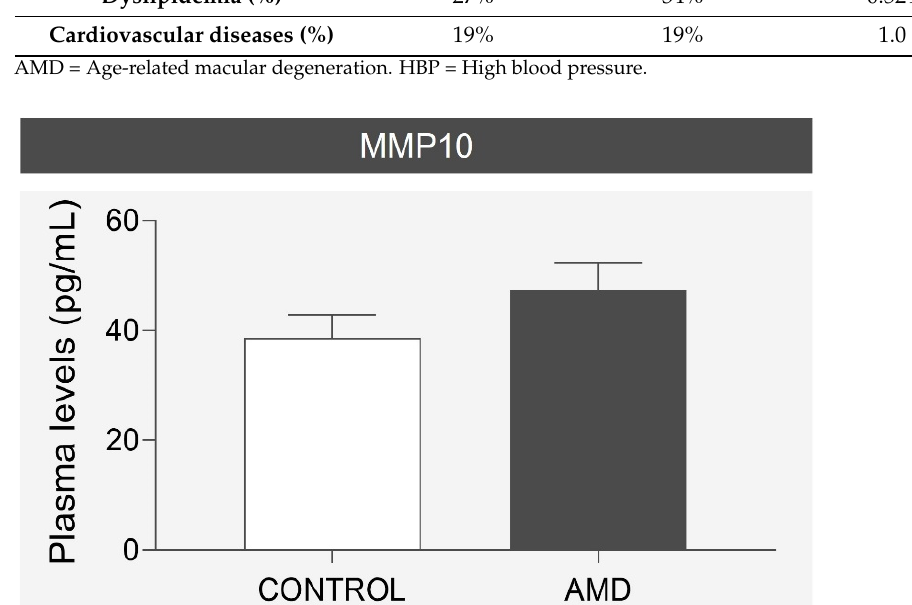
Table 1. Demographic data and clinical characteristics of participants.